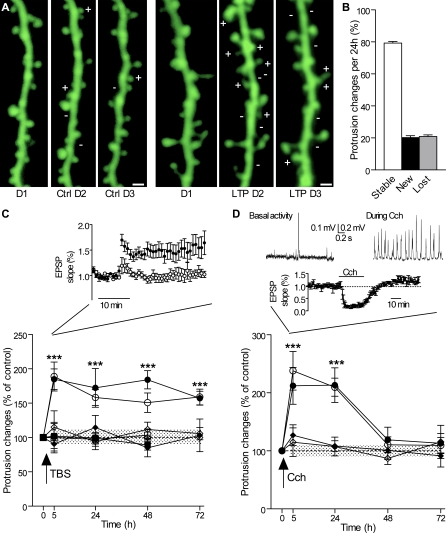
Lasting Increase in Protrusion Turnover Induced by Rhythmic Activity(A) Dendritic segments imaged on three consecutive days under control conditions (Ctrl, D1–D3) or before (D1) and following LTP induction (LTP, D1–D3; [+] new and [−] lost protrusions) (scale bars: 1 μm).(B) Proportion of stable, new, and lost protrusions (spines and filopodia) per 24 h under control conditions (n = 30 cells/1,627 protrusions).(C) Changes in protrusion turnover measured following LTP induction (TBS, circles; n = 17/916), or TBS + 100 μM D-AP5 (diamonds; n = 11/724), or low-frequency stimulation (0.3 Hz; squares; n = 6/183). Filled and empty symbols represent changes in new and lost protrusions, respectively. Data are plotted as percentage of control values with the shaded area representing the confidence interval. The insert shows the changes in EPSP slope measured in the CA1 area before and after LTP induction (filled circles; n = 13) and TBS + 100 μM D-AP5 (open circles; n = 7).(D) Same as in (C) but following theta activity (shown in the insert) induced by treatment with 10 μM Cch (circles, n = 11/723). Diamonds: 10 μM Cch + 100 μM D-AP5 (n = 8/639; ***p < 0.001, 2-way ANOVA with Bonferroni post-tests). The insert illustrates the spontaneous baseline activity of 1–3 Hz observed in one experiment and the increased 5–10 Hz activity induced by Cch. Below are shown the changes in EPSP slope measured during and after Cch treatment (n = 5).